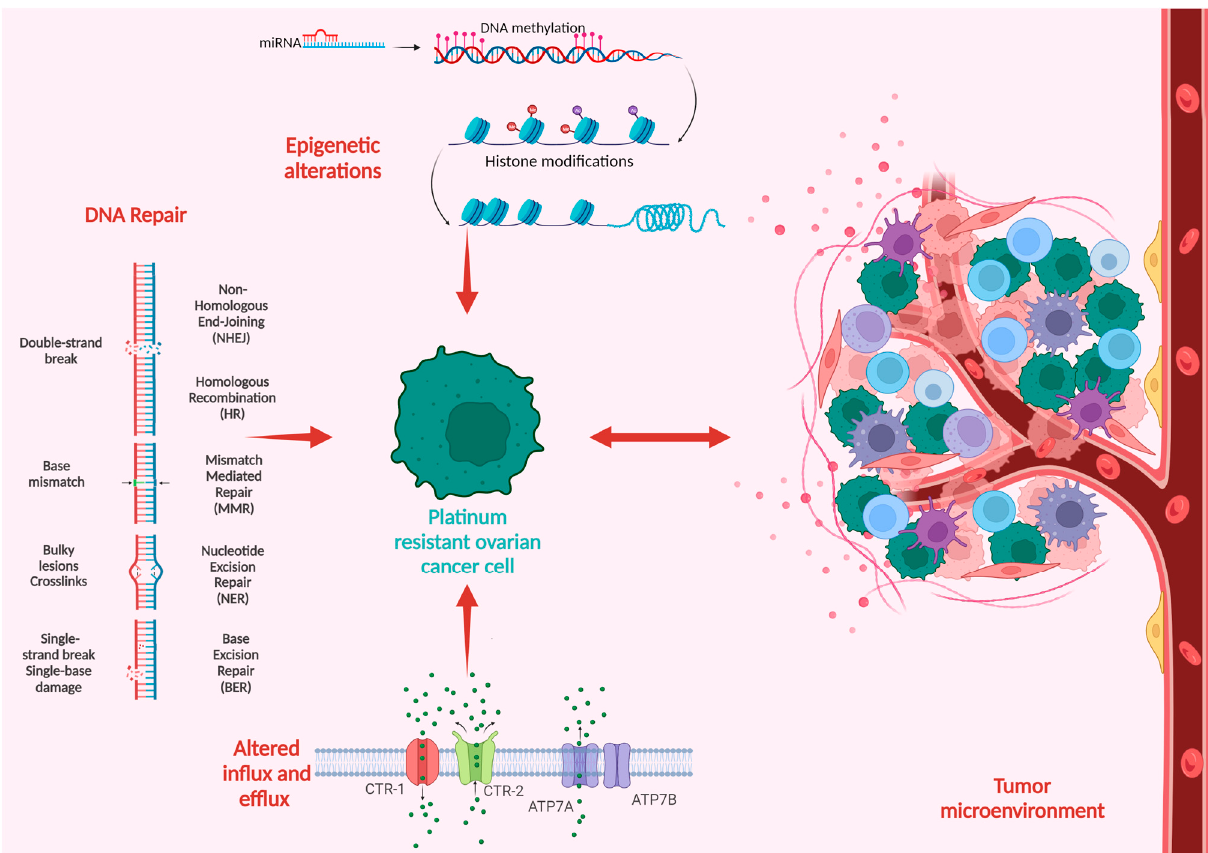
Figure 1. Schematic overview of the mechanisms of platinum resistance in ovarian cancer.